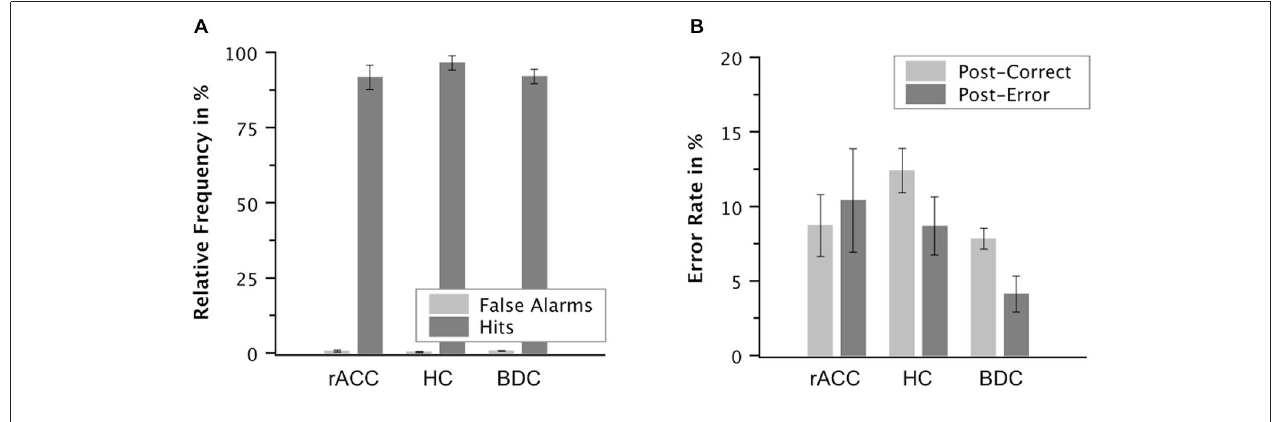
patients with lesions of the rostral anterior cingulate cortex (rACC Group), in healthy controls (HC Group), and in patients with brain lesions outside the frontal lobes (BDC Group, B ). Error bars represent standard errors of the